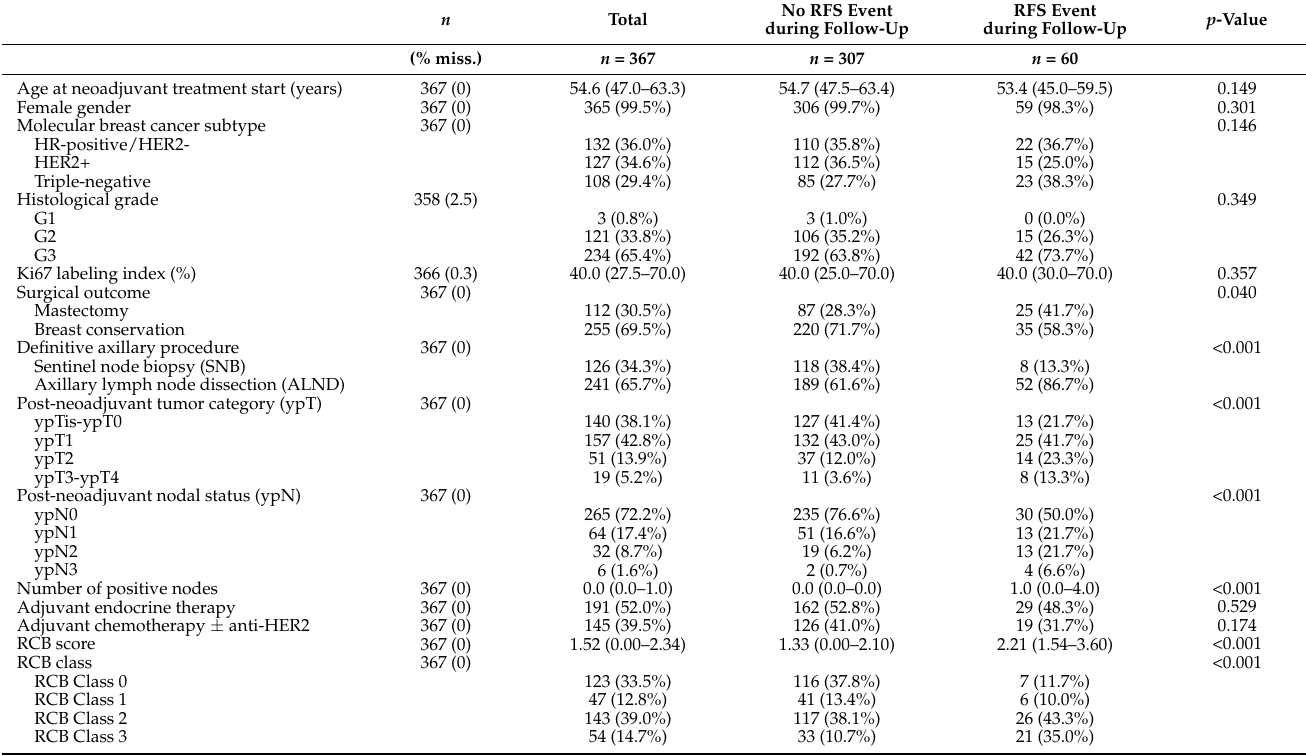
Figure 1. Consort diagram for the study showing number of patients included and reasons for exclusion. Table 1. Baseline characteristics overall and by RFS event